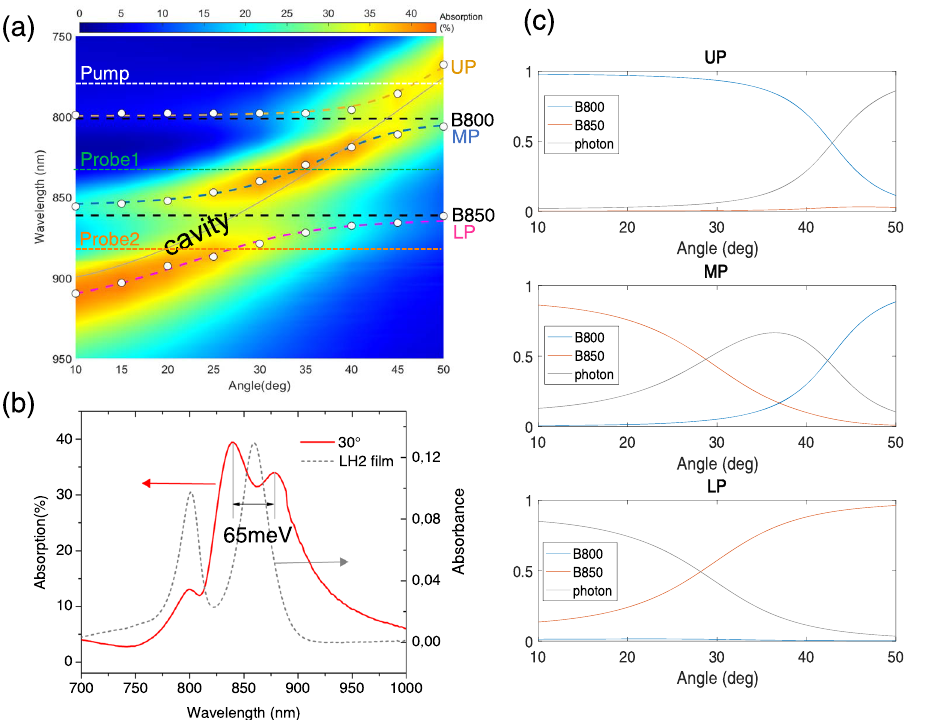
Fig. 2 | Rabi splitting in LH2 polaritons. a Angle-resolved absorption (transverse electric mode) spectra and the fi tting results from a 3-by-3 coupled oscillator model; b absorption spectrum of the strong coupled cavity at 30° (red solid line)